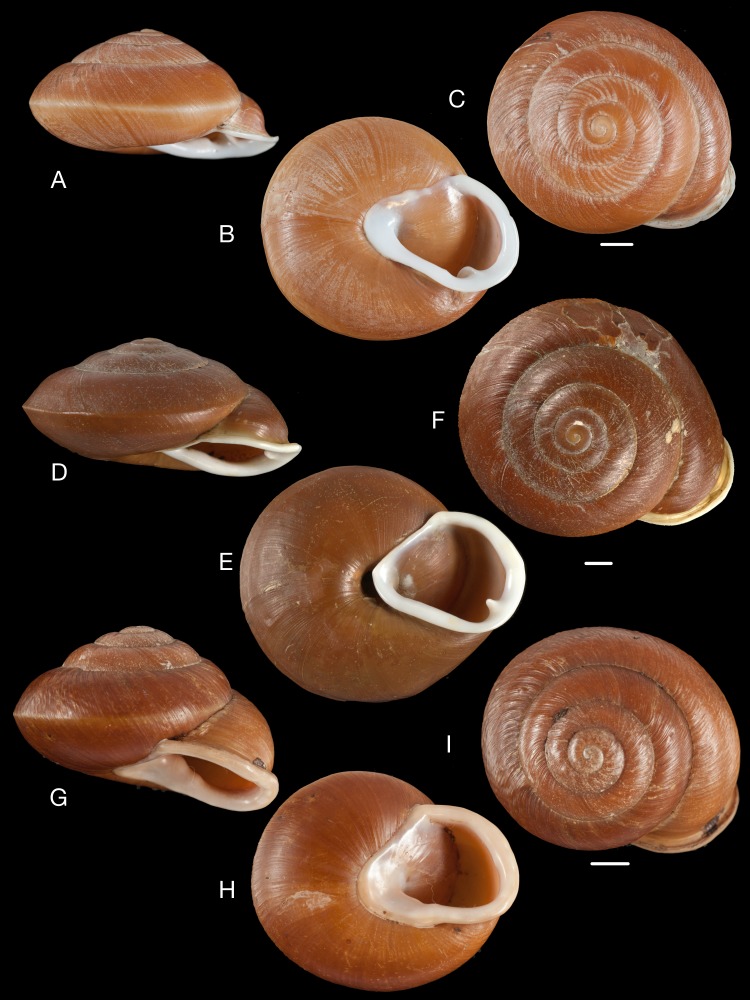
Material collected by the CCP.(A–I) Pleurodontidae. Isomeria globosa (Broderip in Broderip & Sowerby I, 1832), MNCN 15.05/58516, (A) ventral view, (B) umbilical view, (C) apical view; Isomeria jacksoni
Solem, 1966, MNCN 15.05/58512, (D) lateral view (lip), (E) umbilical view, (F) apical view; Isomeria juno (Pfeiffer, 1850), MNCN 15.05/13984, (G) ventral view, (H) umbilical view, (I) apical view. Scale line 5 mm.